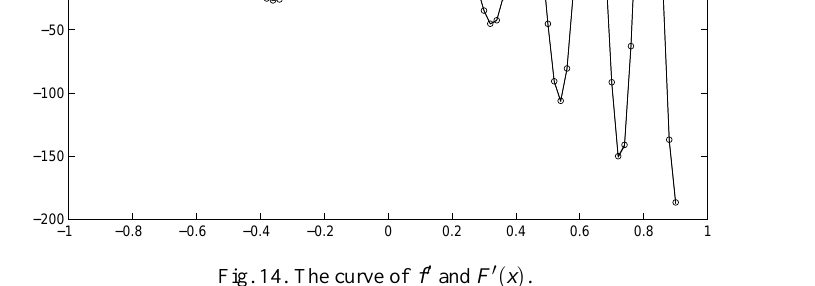
Fig. 14. The curve of f ′ and F ′ ( x )